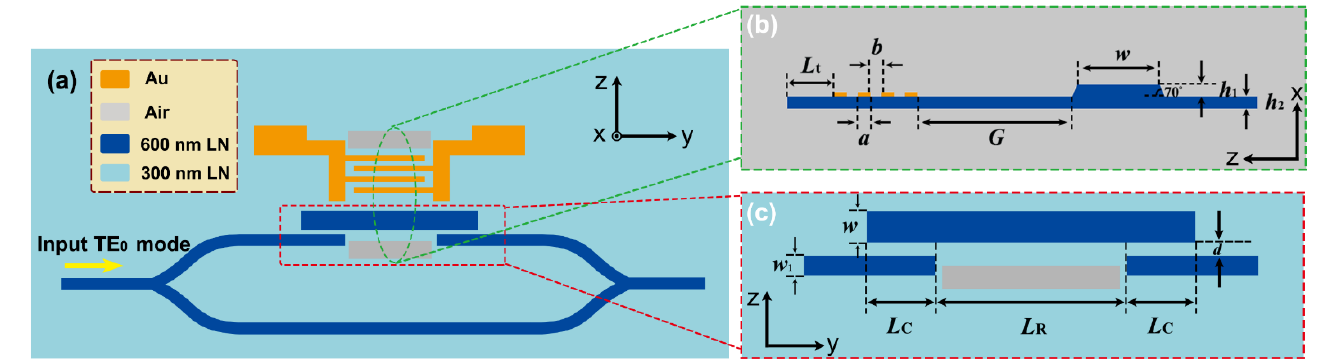
Figure 1. ( a ) Schematic of the proposed AOM working at the higher-order TE 1 mode based on a 600 nm-thick X-cut TFLN. The modulation region is located at one arm of the MZI structure and the other arm is used for reference. ( b ) Cross-sectional view of the AOM in the x – z direction. ( c ) Enlarged view of the mode conversion region. The structural materials and parameters are also labelled.